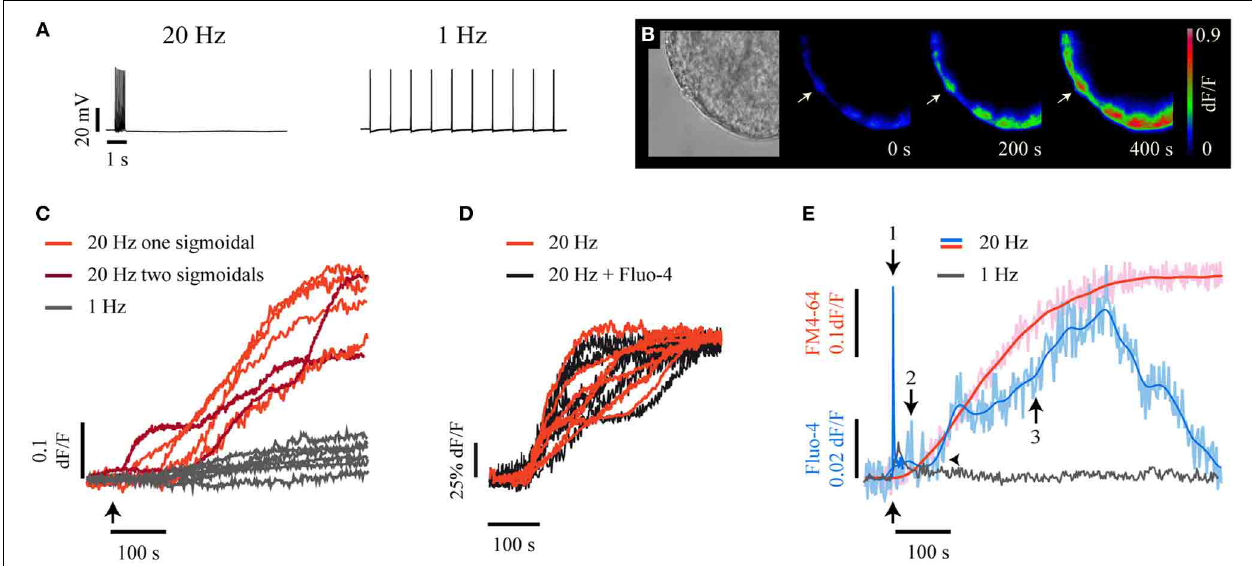
FIGURE 1 | High frequency electrical stimulation evokes long-lasting somatic exocytosis and Ca 2 + signals. (A) Intracellular recordings of trains of 10 impulses at 20Hz (left) and 1Hz (right) produced upon intracellular injection of current pulses. (B) Time course of FM1-43 fluorescence increases. On the left is a bright field equatorial image of a soma. Scale bar = 10 µ m. The sequence on the right shows FM1-43 fluorescence increases at 200 and 400s following 20-Hz electrical stimulation (time = 0s). The arrow points to a well-delimited fluorescent spot of the sort used for our kinetic measurements. The color scale on the right indicates the fluorescence levels in arbitrary units. (C) Kinetics of FM1-43 fluorescence from six individual spots, each produced by a different neuron in response to 20-Hz stimulation. The arrow indicates the onset of stimulation. The light-red kinetics were described by one sigmoidal, while the two dark-red kinetics were described by two or three sigmoidal steps. The gray traces were obtained from equivalent membrane areas from six other neurons stimulated at 1Hz. These